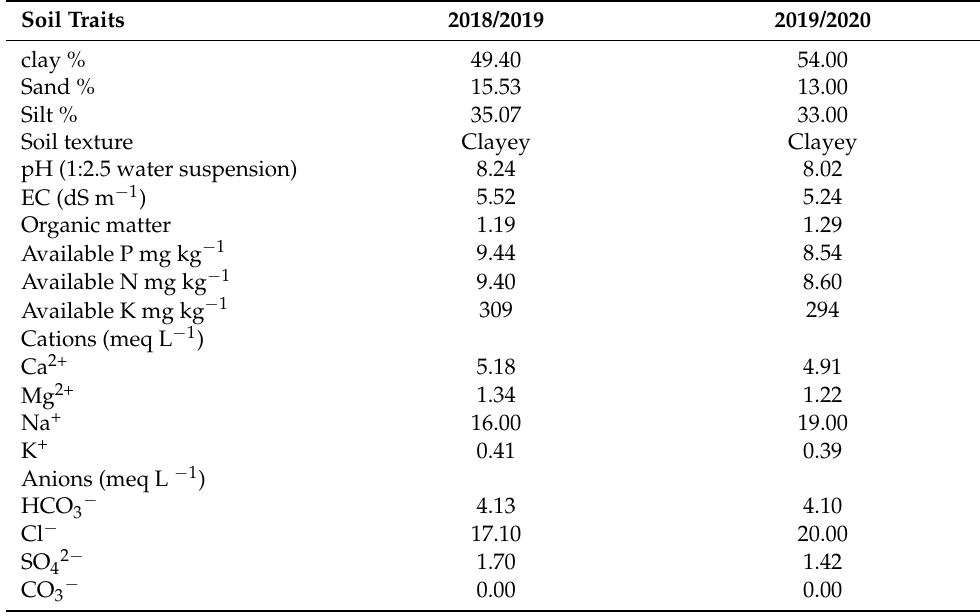
Table 4. Soil physicochemical traits in the two winter seasons 2018/2019 and 2019/2020. Soil